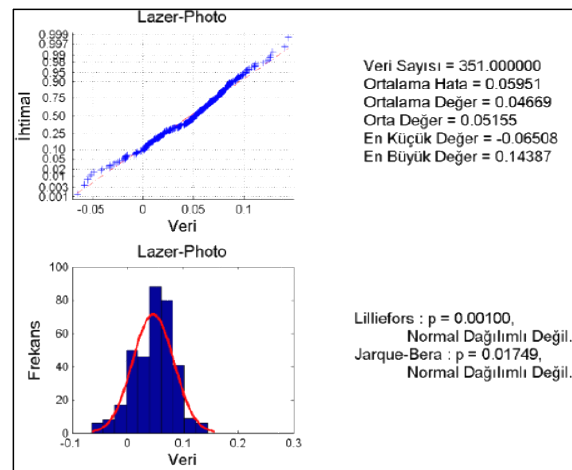
Figure 6: Laser-Photo Comparing with statistical